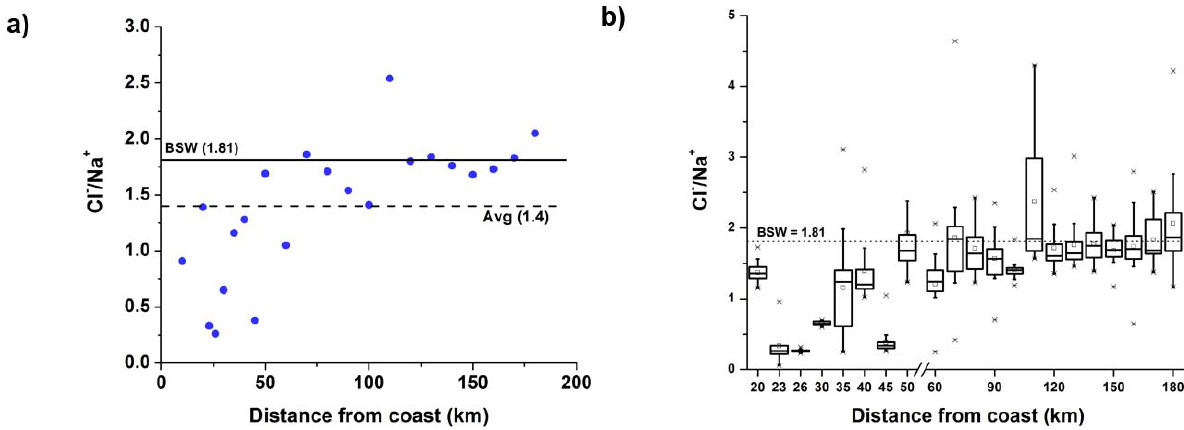
Fig. 4. (a) Average annual Cl − /Na + ratios from coast to inland. The dashed line is the annual average Cl − /Na + ratio along the entire transect and the solid line is bulk sea water (BSW) ratio. (b) Seasonal variability in Cl − /Na + ratios from the entire transect. Please note the break in scale along the x-axis. Table 2. Seasonal and annual average concentrations of Na + , Cl − and SO 2 −